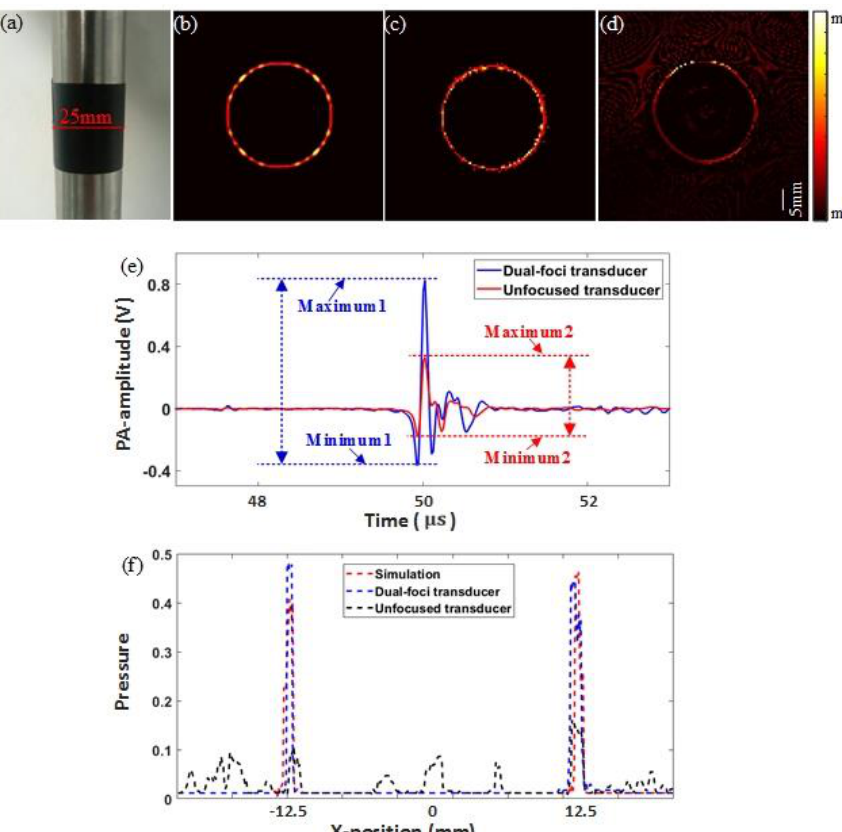
Figure 6. ( a ) Phantom of the comparative experiment. ( b ) Reference standard image by K-Wave simulation. Reconstructed PA images obtained with ( c ) the dual-foci transducer and ( d ) the traditional unfocused transducer. ( e ) A-Line plots from dual-foci transducer and traditional unfocused transducer. ( f ) Absorption intensity distribution at the centerline of (a – c).